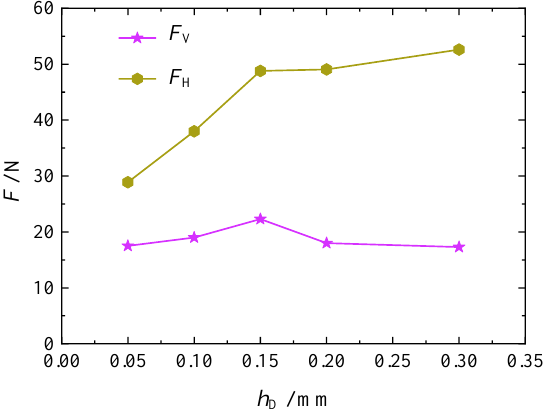
Figure 3. Cutting force at different cutting thicknesses.